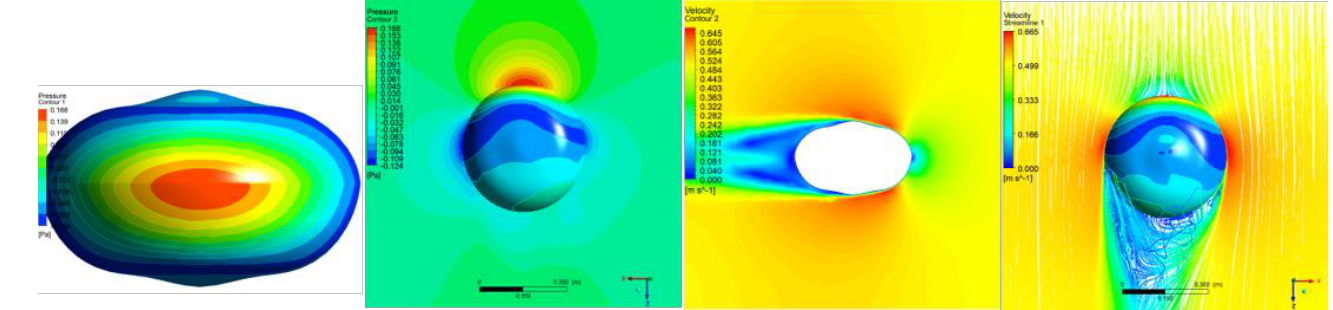
angle in the range of 18 – 72° compared to the shell without fins. That means AUH would yaw angle in the range of 18 −7 2° along the current course. This section analyzes the fins’ effect on the yaw angle during horizontal motion, and an underwater experiment is executed to evaluate the actual control impact in Section 4.